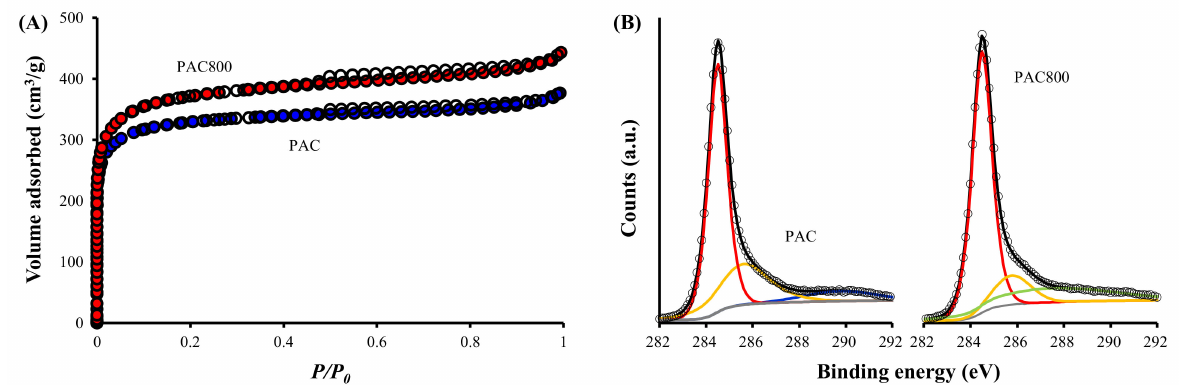
Figure 1. ( A ) N 2 adsorption/desorption and ( B ) C1s XPS spectra of PAC and PAC800.